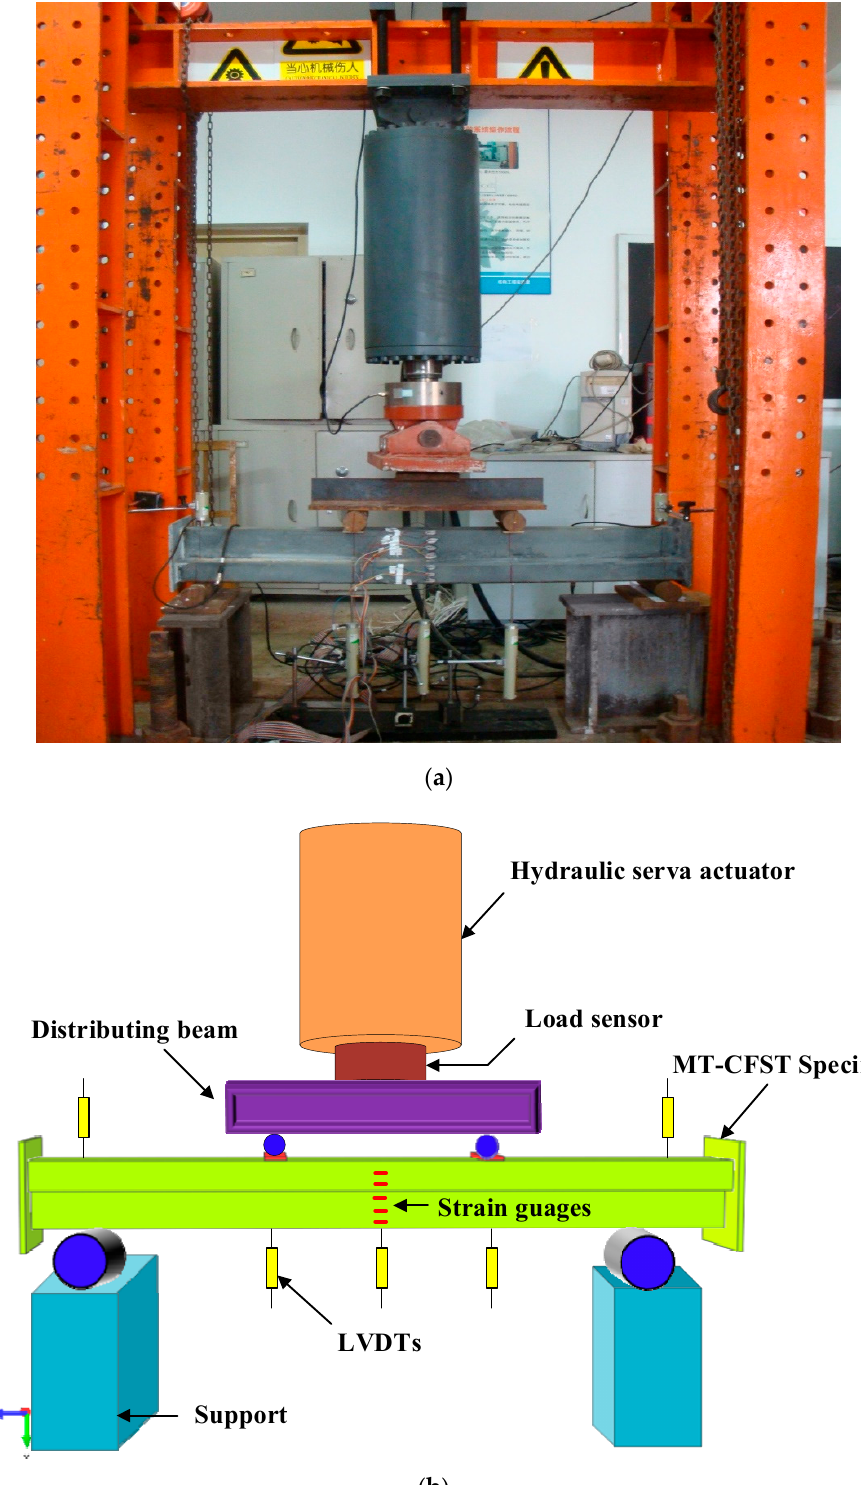
Figure 7. A general view of the four-point bending test and schematic diagram of the test setup: ( a ) Four-point bending test of MT-HST specimen; ( b ) schematic diagram of the test setup.